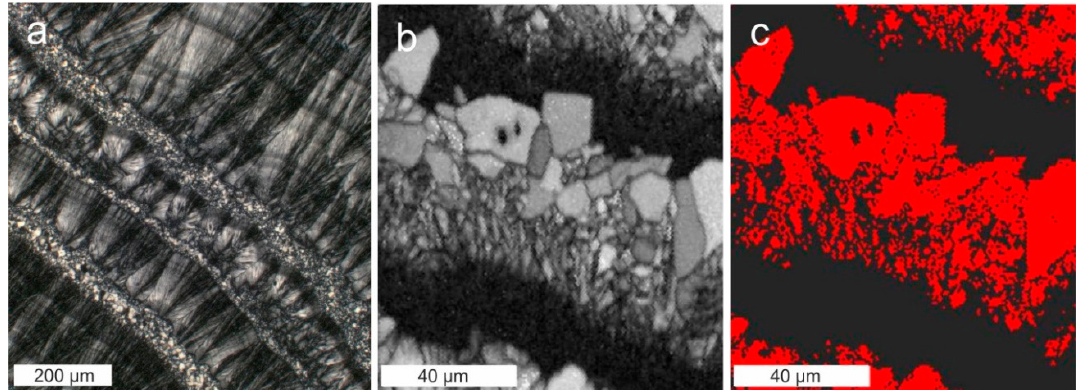
Figure 30. Micrographs showing the development of the band micro ‐ structure in agates: ( a ) rhythmic banding of granular quartz and fibrous chalcedony in an agate from Los Indios (Cuba); ( b ) electron backscatter diffraction (EBSD) band contrast image revealing an increase in brightness with increasing SiO 2 crystallinity; ( c ) EBSD micrograph showing the distribution of α‐ quartz (red colour) in the agate bands; ( b , c ) demonstrate that the dark band areas consist of amorphous or strongly disordered silica.